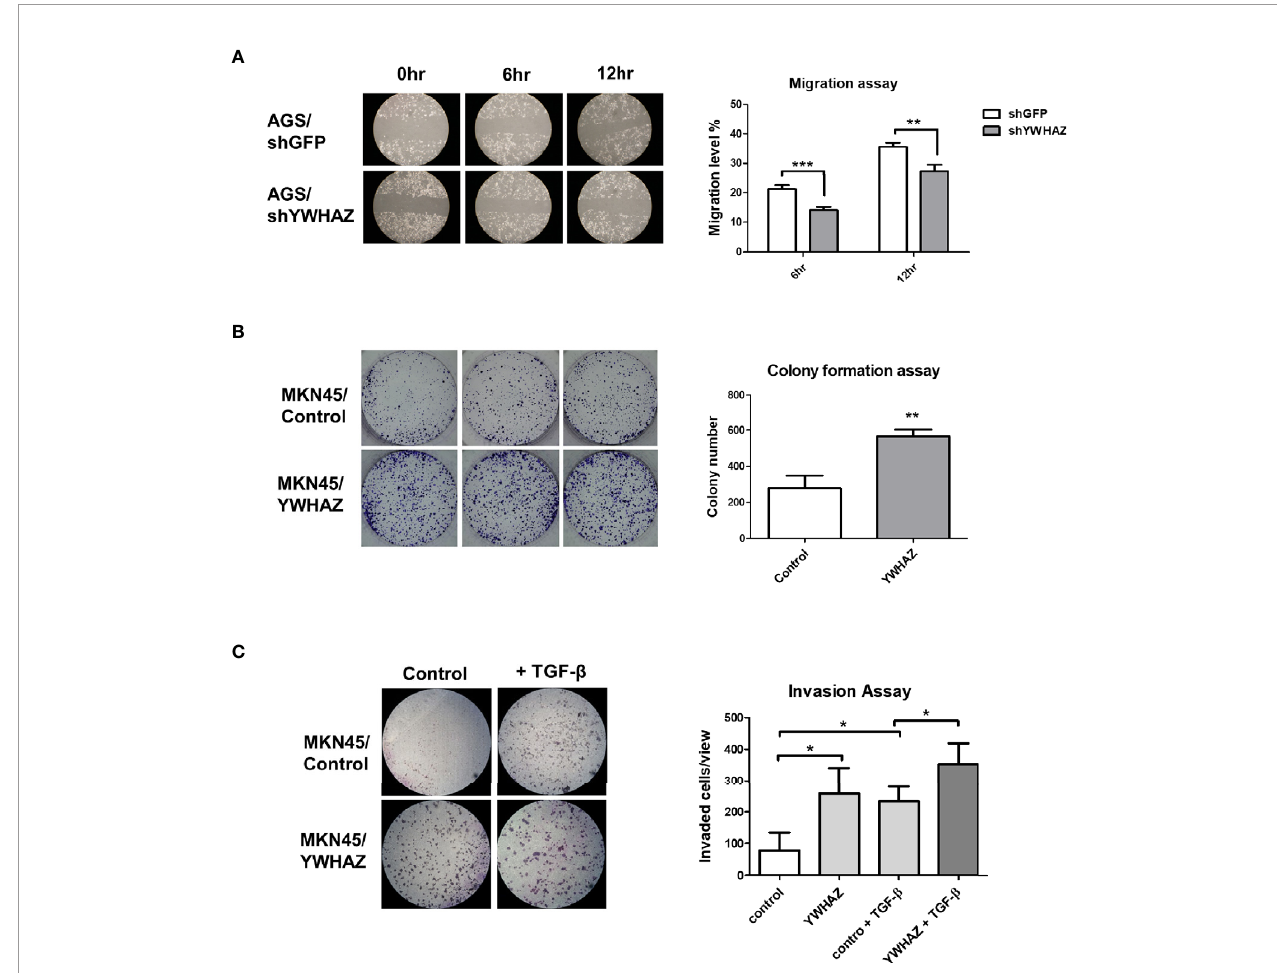
FIGURE 4 | YWHAZ regulates proliferation, migration and invasion in gastric cancer cells. (A) Migration of AGS cells were infected with shRNA against GFP (shGFP, control) or YWHAZ (shYWHAZ) in AGS gastric cancer cells, as determined by wound healing assay. Right panel shows the quantitative analysis of the assay. MKN45 transfected control (pcDNA, MKNB45/Control) or YWHAZ expressing plasmid (MKN45/YWHAZ), were used to perform (B) colony formation assay, and (C) transwell invasion assay. Addition of TGF- b further enhanced the invasion ability of YWHAZ-overexpressing MKN45 cells. Quantitative analysis was shown in the right panel. Each bar represents mean ± SD of duplicate experiments (*P < 0.05, **p < 0.01; ***p <